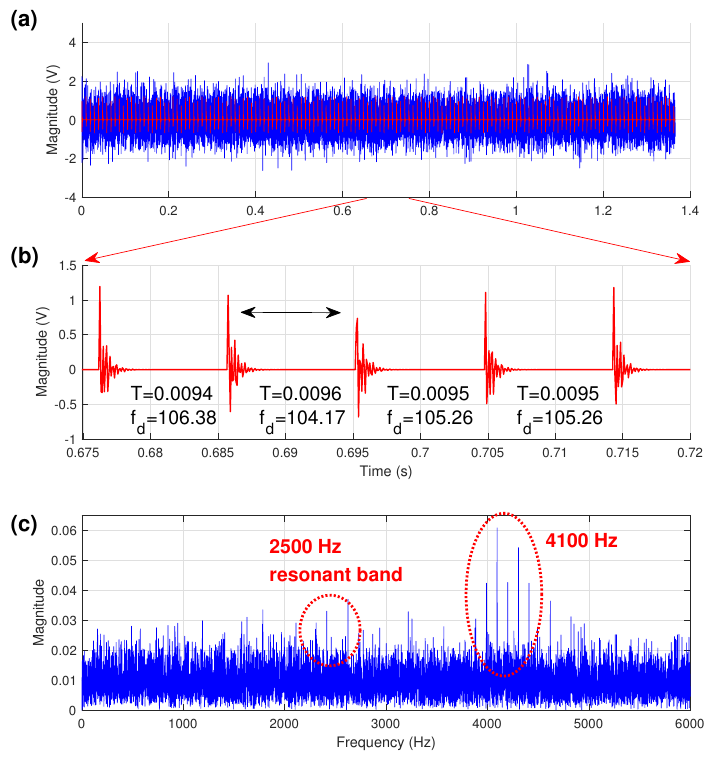
Figure 3. The simulation signal ( a ) time signal with noise (the red waveform represents the uncon- taminated signal), ( b ) a part of impulse signal, and its ( c ) amplitude